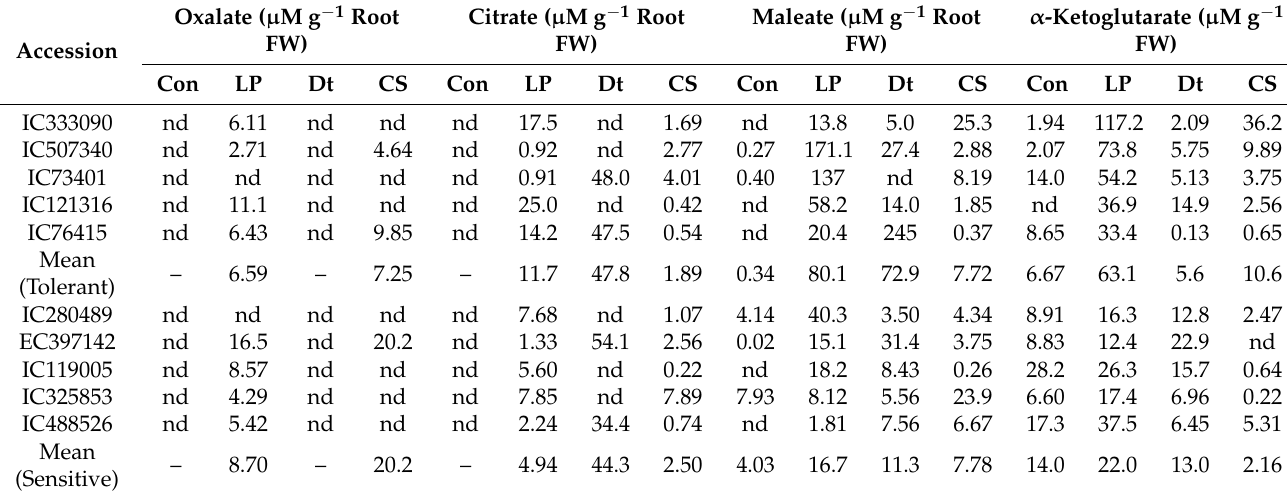
Table 3. Effect of P nutrition and drought on exudation of organic acids (oxalate, citrate, maleate, and α -Ketoglutarate) from roots of selected mungbean accessions grown at two P levels (sufficient, 25.6 mg P kg − 1 dry soil, and low P, 7.8 mg P kg − 1 dry soil) and two moisture regimes (irrigated and drought). ‘nd’—not detectable; Con—Control; LP—Low phosphorus; Dt—Drought; CS—combined